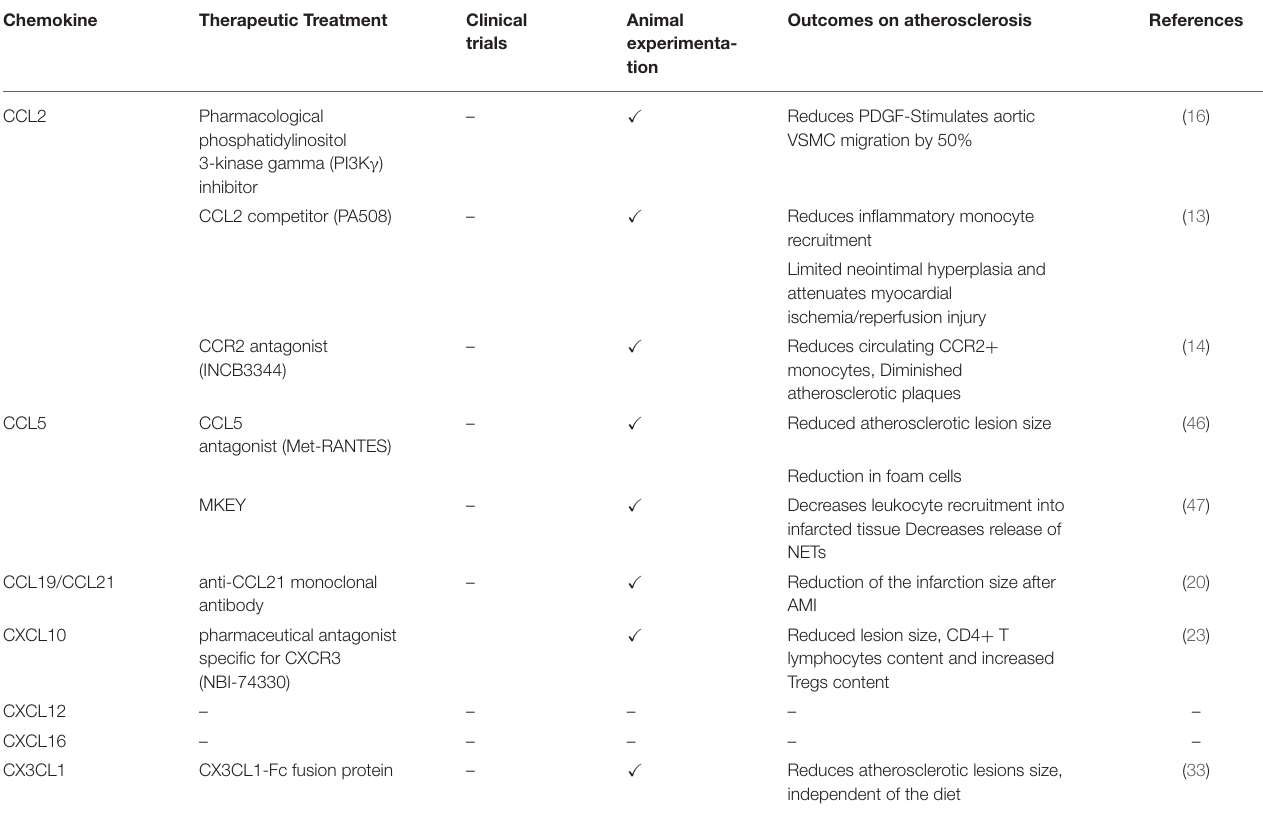
TABLE 2 | Targeting chemokines as therapeutic treatments in vascular remodeling and CVD.